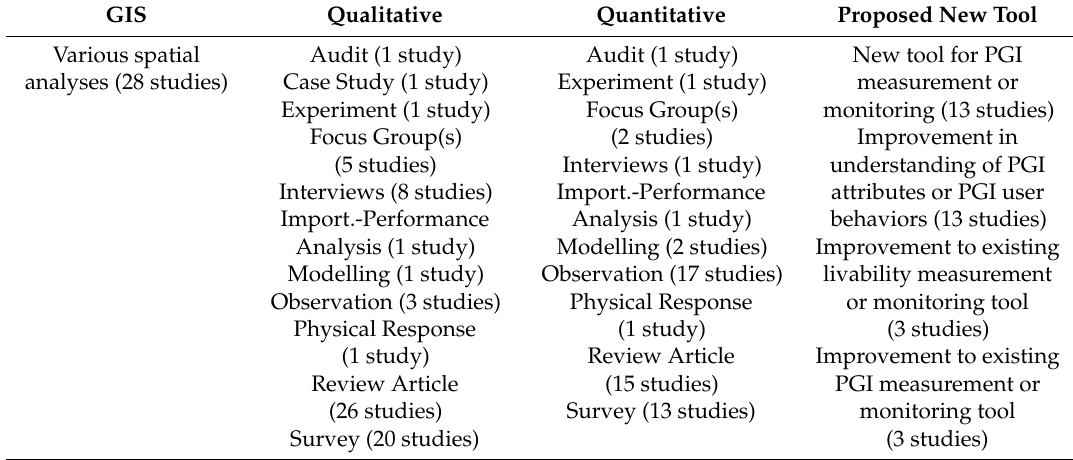
Table 3. Research approaches utilized, validated, or recommended under each research category by study (Figure